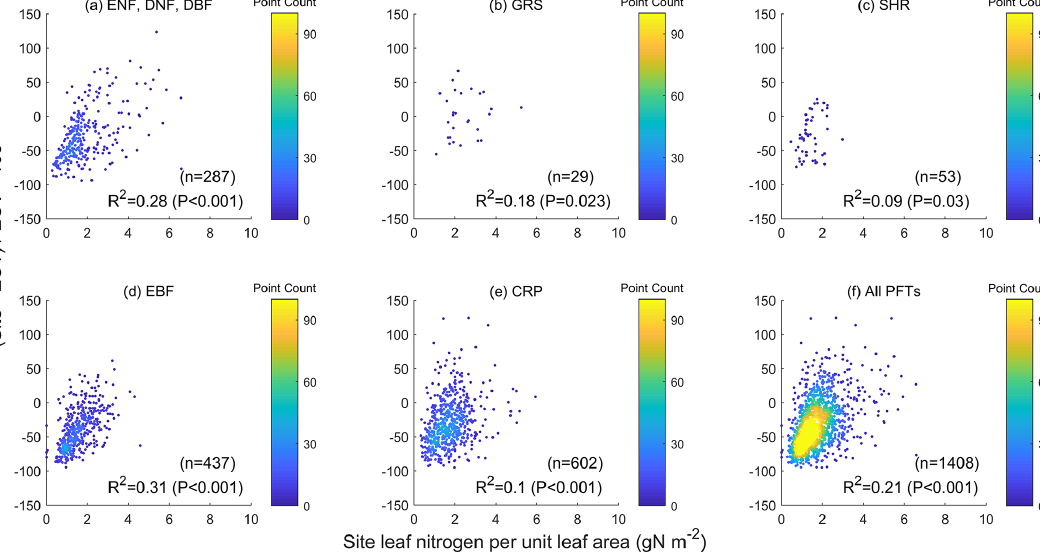
Figure 7. Influence of leaf nitrogen content on the relative difference between V cmax T ecological optimality theory (EOT) using the available database (Smith et al., 2019). The influence is highly significant for all plant functional types (i.e., p< 0 . 001). The slopes of the regressions of the relative difference in V cmax against LCC or ground leaf nitrogen data are similar, in agreement with the global modeling results that levels of nutrient limitation to plant growth are similar among different PFTs (Fisher et al.,